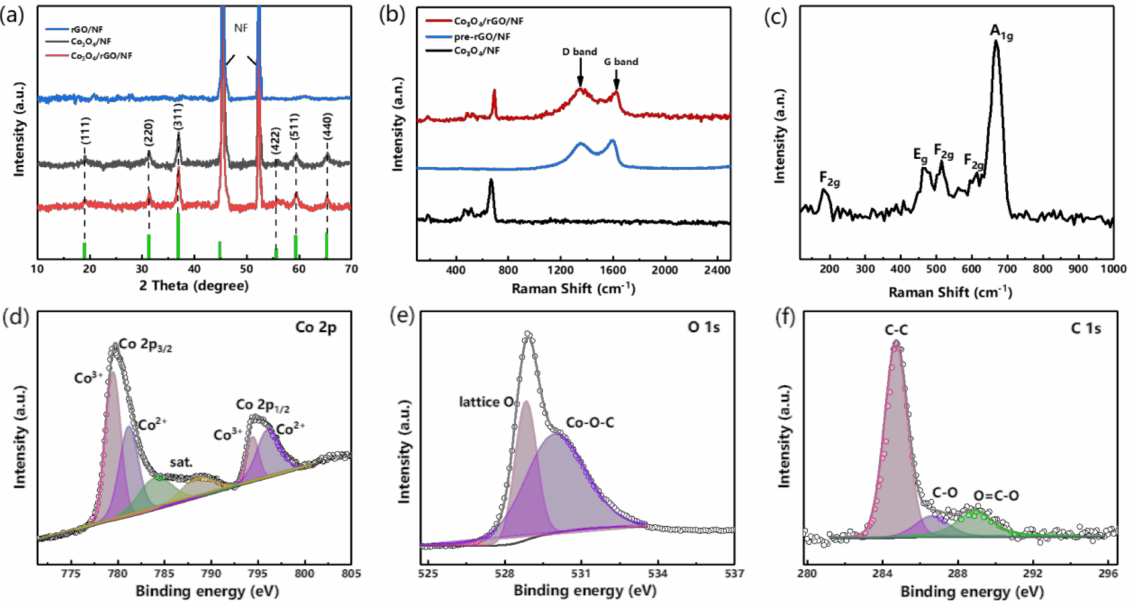
Figure 2. ( a ) Comparison of XRD patterns. Raman spectra of ( b ) Co 3 O 4 /rGO/NF, pre − rGO/NF, and Co 3 O 4 /NF samples and ( c ) fine spectrum of Co 3 O 4 . XPS spectra of ( d ) Co − 2p, ( e ) O − 1s, and ( f ) C − 1s of Co 3 O 4 /rGO/NF